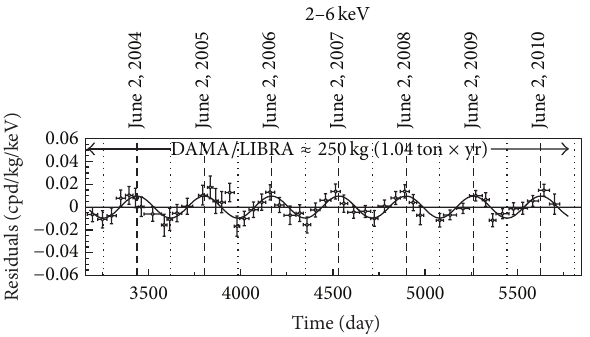
Figure 1: Experimental residual rate of the single-hit scintillation events measured by DAMA/LIBRA-phase1 in the (2–6) keV energy interval as a function of the time. The data points present the exper- imental errors as vertical bars and the associated time bin width as horizontal bars. The superimposed curves are the cosinusoidal functions behaviour A cos 𝜔(𝑡 − 𝑡 0 ) with a period 𝑇 = 2𝜋/𝜔 = 1 yr, a phase 𝑡 0 = 152.5 day (June 2nd) and modulation amplitudes, 𝐴 , equal to the central values obtained by best fit on the data points of the entire DAMA/LIBRA-phase1. The dashed vertical lines correspond to the maximum expected for the DM signal (June 2nd), while the dotted vertical lines correspond to the minimum.